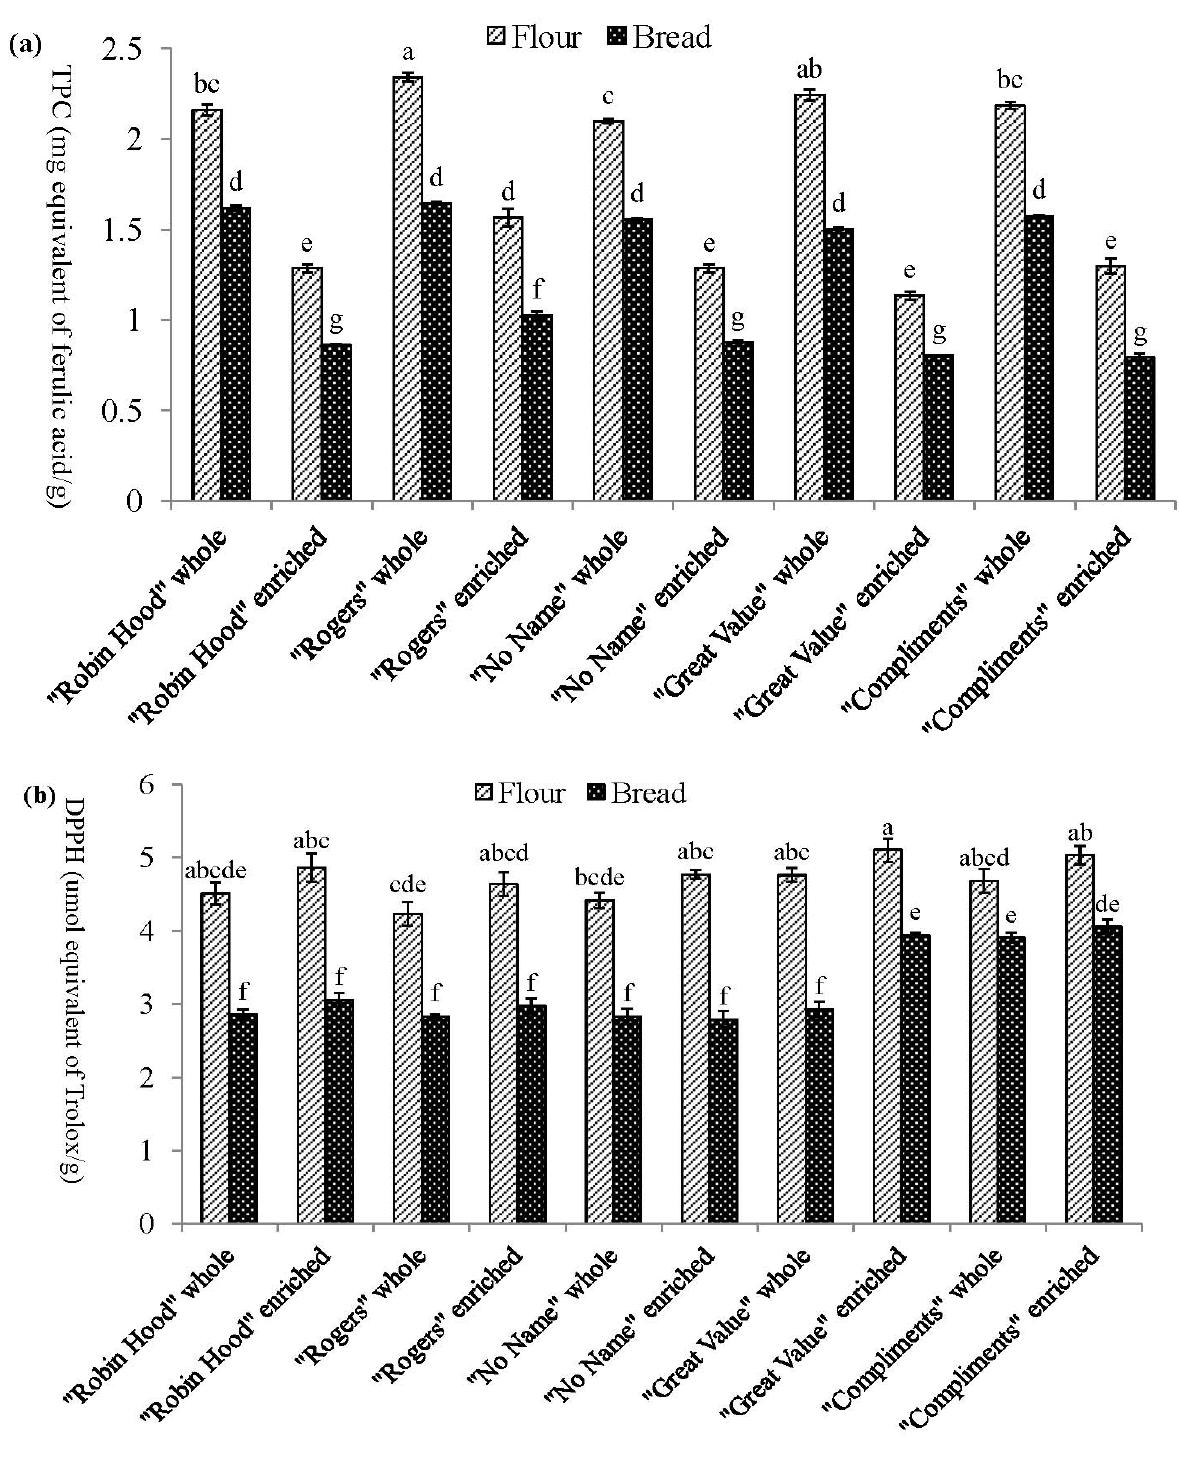
Figure 1. ( a ) Total phenolic content (TPC) ( b ) 2,2-diphenyl-1-picrylhydrazyl (DPPH) radical scavenging activity and ( c ) oxygen radical scavenging absorbance capacity (ORAC) of soluble phenolic compounds from flours and corresponding breads